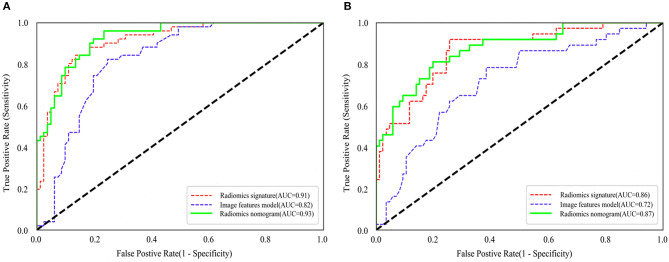
Comparison of ROC curves between radiomics nomogram, image features model and radiomics nomogram for prediction of tumor necrosis in the training cohort (A) and validation cohort (B). The three colors of the curves represent different models: red, radiomics signature; blue, image features model; green, radiomics nomogram.